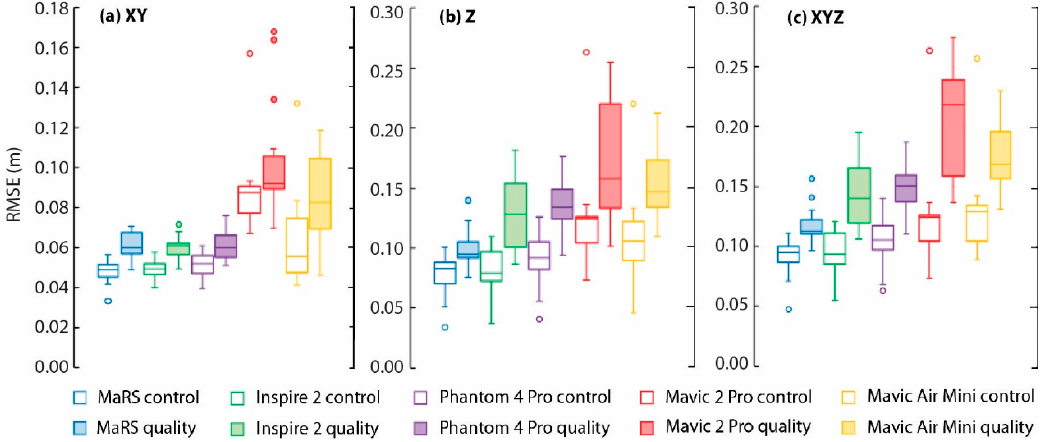
Figure 5. RMSE on control and quality points for Monte Carlo analysis on each sUAS-structure-from-motion (SfM) aircraft. A total of 50 self-calibrating bundle adjustments were carried out with a marker precision of 0.03 m and different random selections of 10 GCPs used as control points and 9 GCPs used as quality points. The center line in each box represents the median RMSE, and the box extends between the 25th and 75th percentiles. The whiskers represent the full range of the results, while the circles represent any outliers. In the figure, ( a ) xy is the horizontal errors, ( b ) z is the vertical errors, and ( c ) xyz is the horizontal and vertical errors combined.